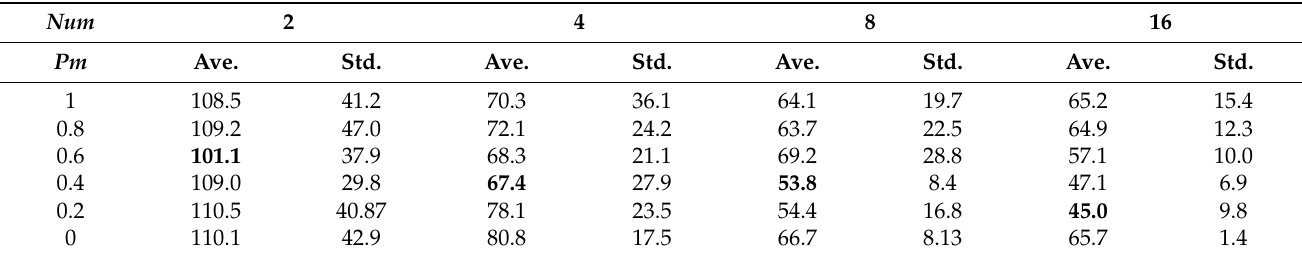
Table 9. Convergence time with different P m in scenario